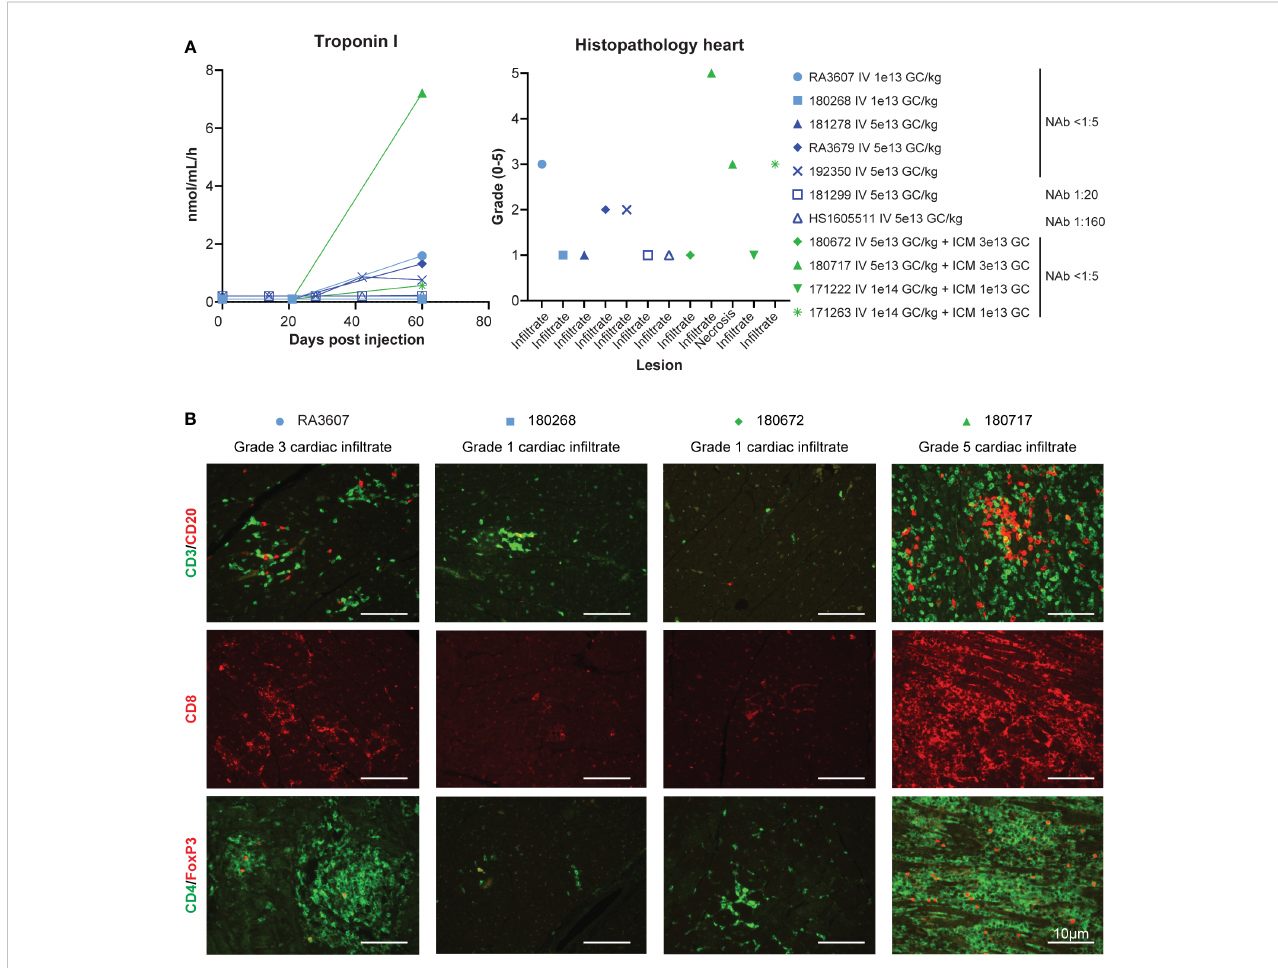
FIGURE 3 Safety, cardiac toxicity. (A) Cardiac troponin I levels and cardiac histopathology from the eleven rhesus macaques presented in the previous fi gures. Cardiac fi ndings (in fi ltrate and/or necrosis) were graded by a board-certi fi ed veterinary pathologist (ELB) on the following severity scale: 0 (within normal limits), 1 (minimal mononuclear in fi ltrates, similar to what is commonly observed as background in macaques), 2 (mild), 3 (moderate), 4 (marked), and 5 (severe). When different scores were given to different cardiac regions (ventricle, atrium, septum), the worst score is presented here. For full scoring result see Table S4. (B) Immunophenotyping of the mononuclear cell in fi ltrate by immuno fl uorescence on heart tissue sections via T-cell-speci fi c